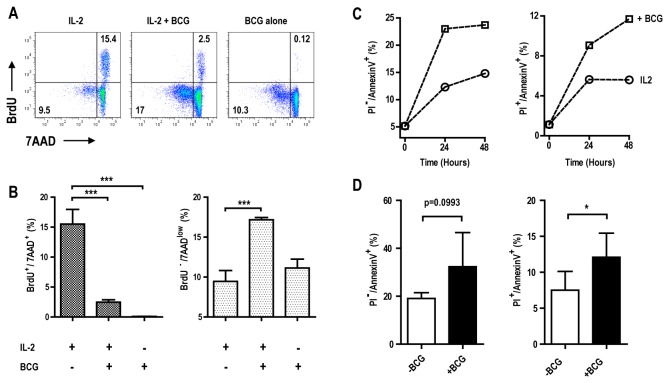
IL-2 dependent induction of NK cell apoptosis by
M.
bovis BCG.A) Representative FACS dot-plot of purified NK cells co-cultured or not
with M.
bovis BCG (MOI 1:5) and IL-2 (100U/ml)
for 4 days before BrdU incorporation, antibody detection and 7AAD
staining (One of three technical replicates). B) Bar graph showing on
the left, the frequency of replicating events
(BrdU+/7AAD+) and, on the right, the frequency
of apoptotic events (BrdU-/7AADlow) of NK cells
from one donor exposed or not to mycobacteria and IL-2 (Mean +/- SD of
technical triplicates, unpaired t test, *** p<0.001). C) Frequencies
of early (PI+/Annex V-) versus late apoptotic
events (PI+/Annex V+) over the time of purified NK
cells cultured or not with M. bovis
BCG (MOI 1:1) and IL-2 (100U/ml). D) Bar graph summarizing frequencies
of apoptotic events after 48h of culture with or without mycobacteria
and IL-2 from independent experiments and donors (n=3, paired t test,
*p<0.05).